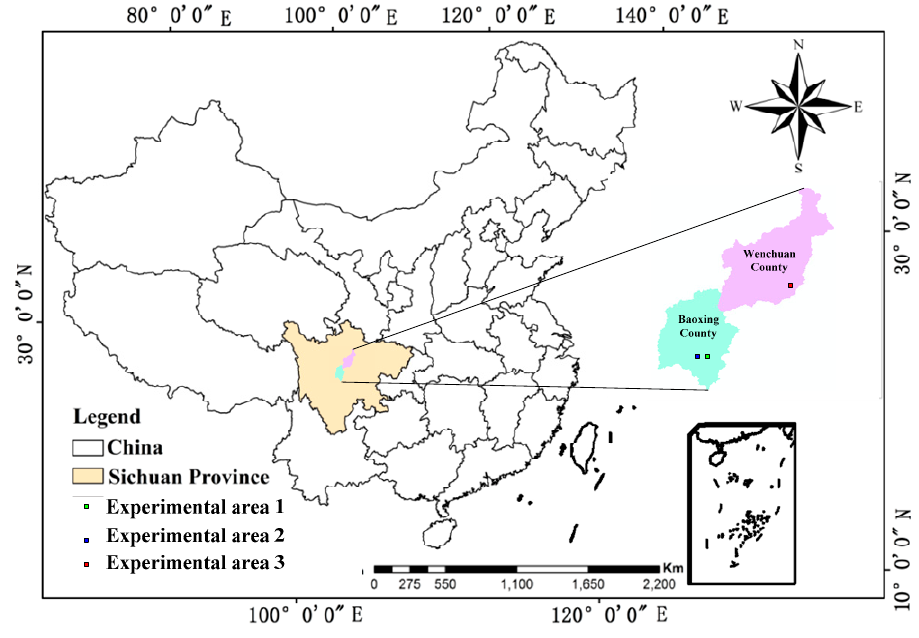
Figure 1. Location of study area.